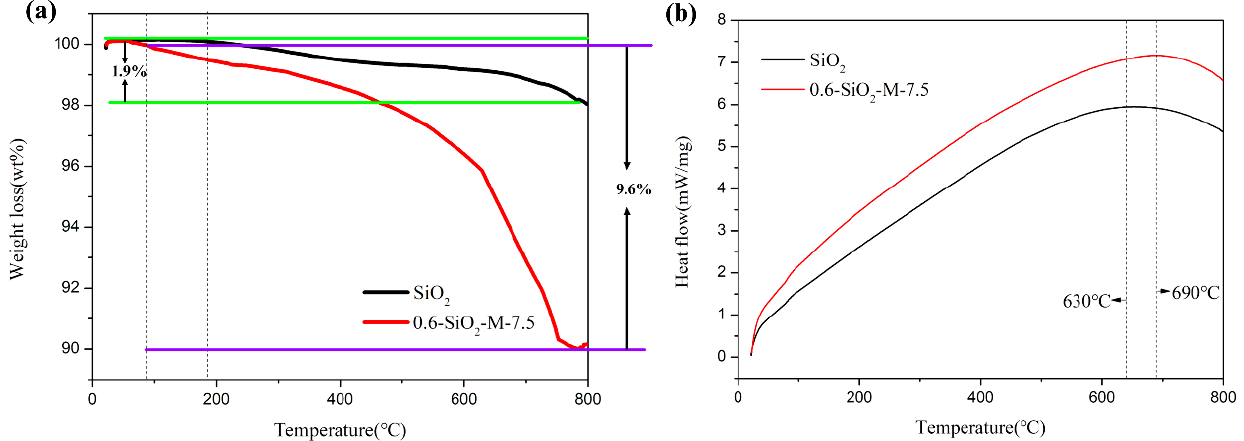
Figure 4. TGA curves of SiO 2 and 0.6-SiO 2 -M-7.5 ( a ); DSC curves of SiO 2 and 0.6-SiO 2 -M-7.5 ( b ).